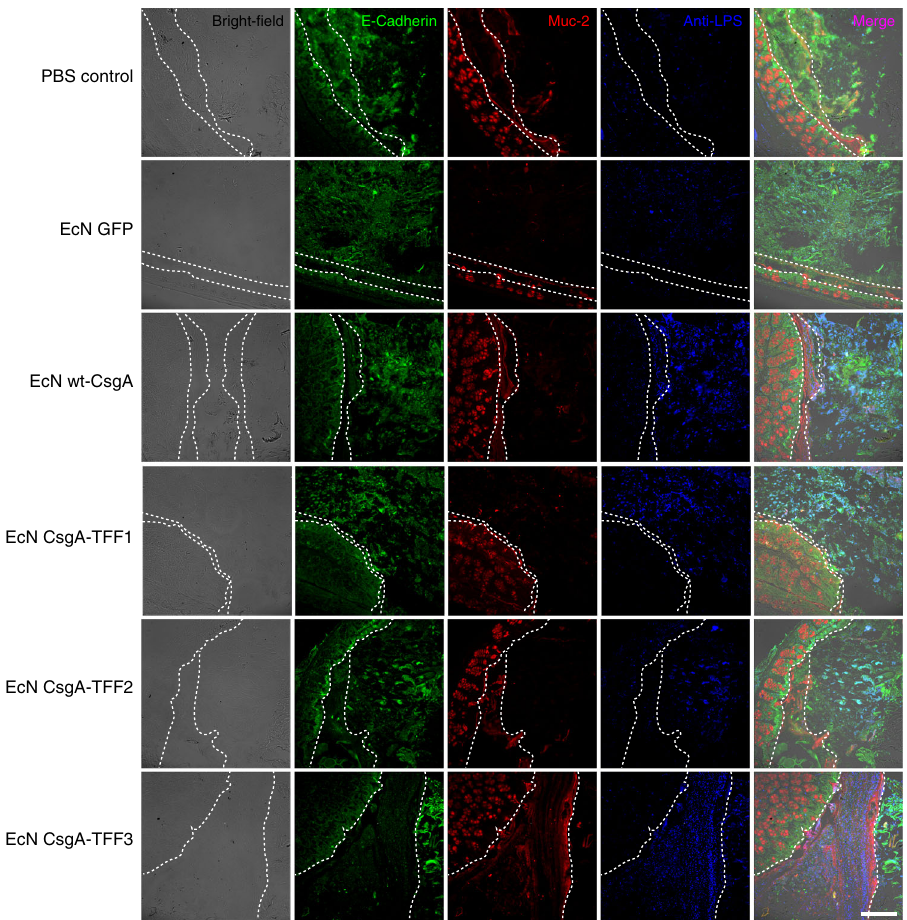
Fig. 5 Immunohistological visualization of engineered EcN strains in tissue sections. These sections are taken from proximal colons of mice receiving different bacteria. Sectioning protocol was designed to preserve mucus and luminal content. Sections were stained with fl uorescently labeled antibodies: anti-E-cadherin (green), anti-Muc2 (red), and anti-LPS (blue). The fi rst column shows bright- fi eld images of the sections. The last column shows an overlay of all stains. The white dotted lines represent the boundary of the epithelium and mucus layers. The leftmost parts represent the epithelium, the center parts represent the mucus layers and the rightmost parts represent the lumen (scale bar = 100 μ